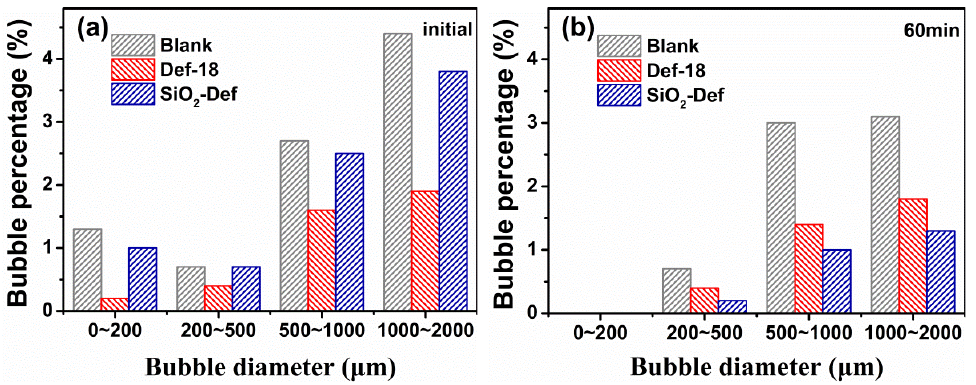
Figure 10. Effect of Def-18 and SiO 2 -Def on the bubble size distribution of the fresh mortar (( a ) initial, ( b ) 60 min).